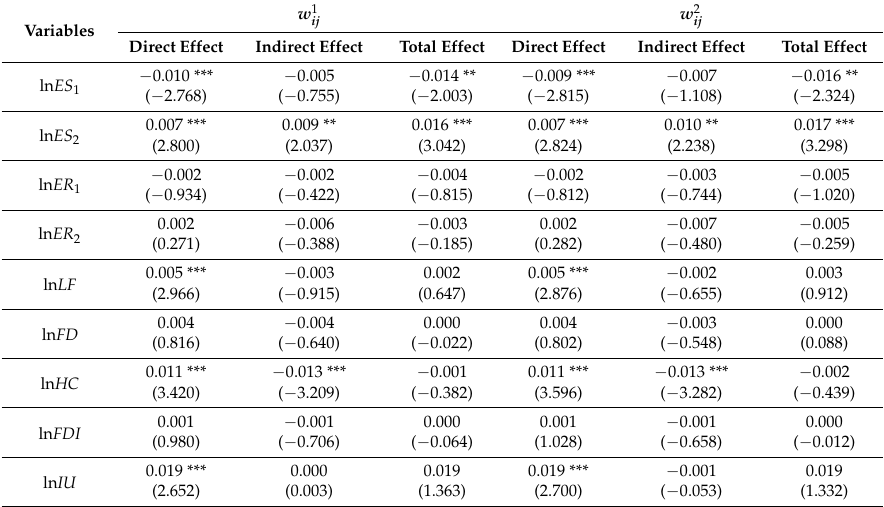
Table 5. The direct, indirect and total effects of the whole